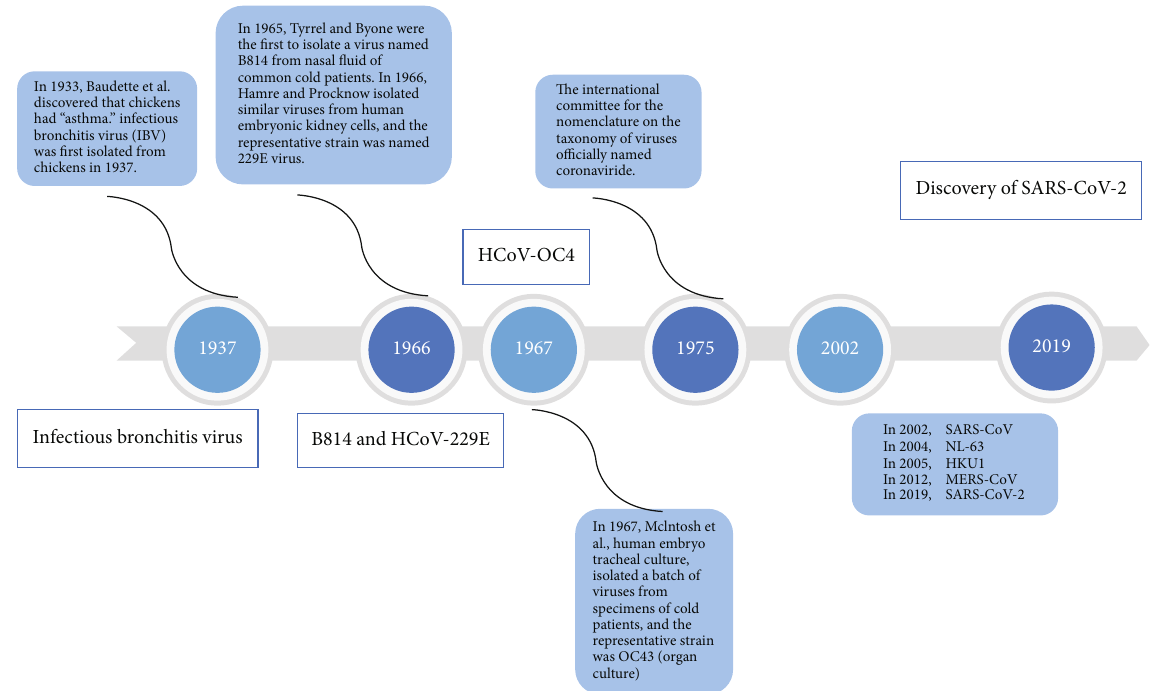
Figure 1: The discovery process of human